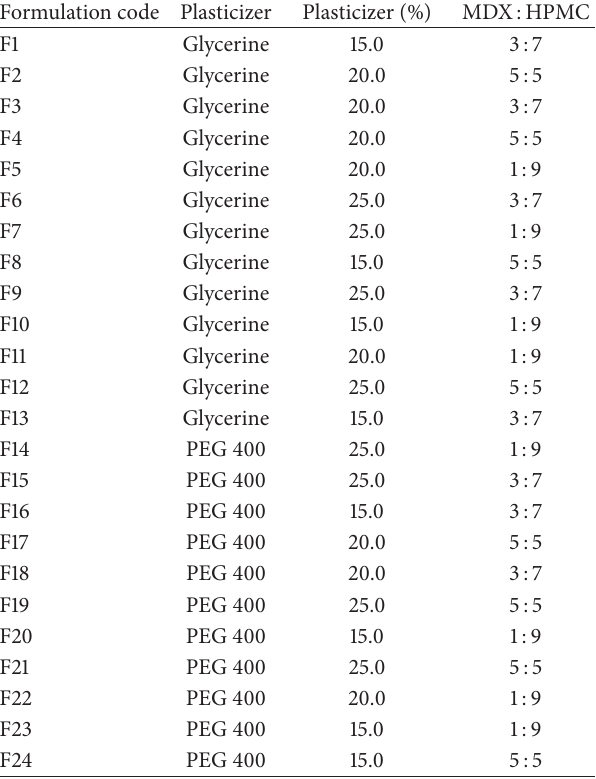
Table 1: Optimal design of OS of DSL (Design-Expert version 8 software).